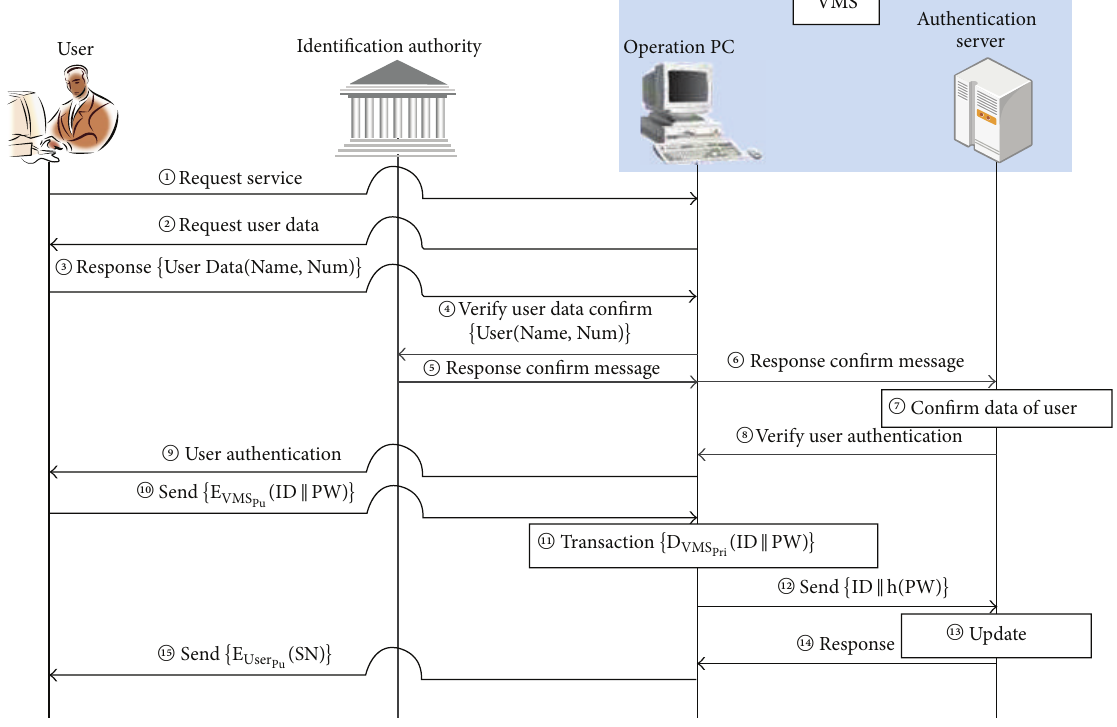
Figure 7: Proposed user registration